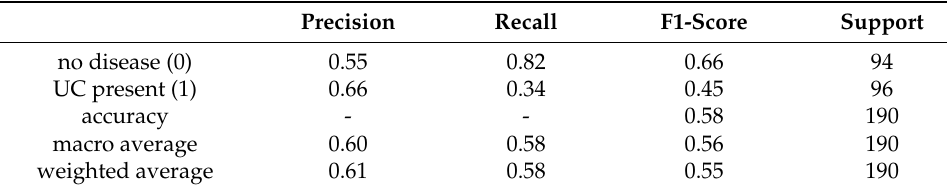
Table 6. Metrics for the CRP level-based model for UC prediction. Precision Recall F1-Score Support no disease (0) 0.55